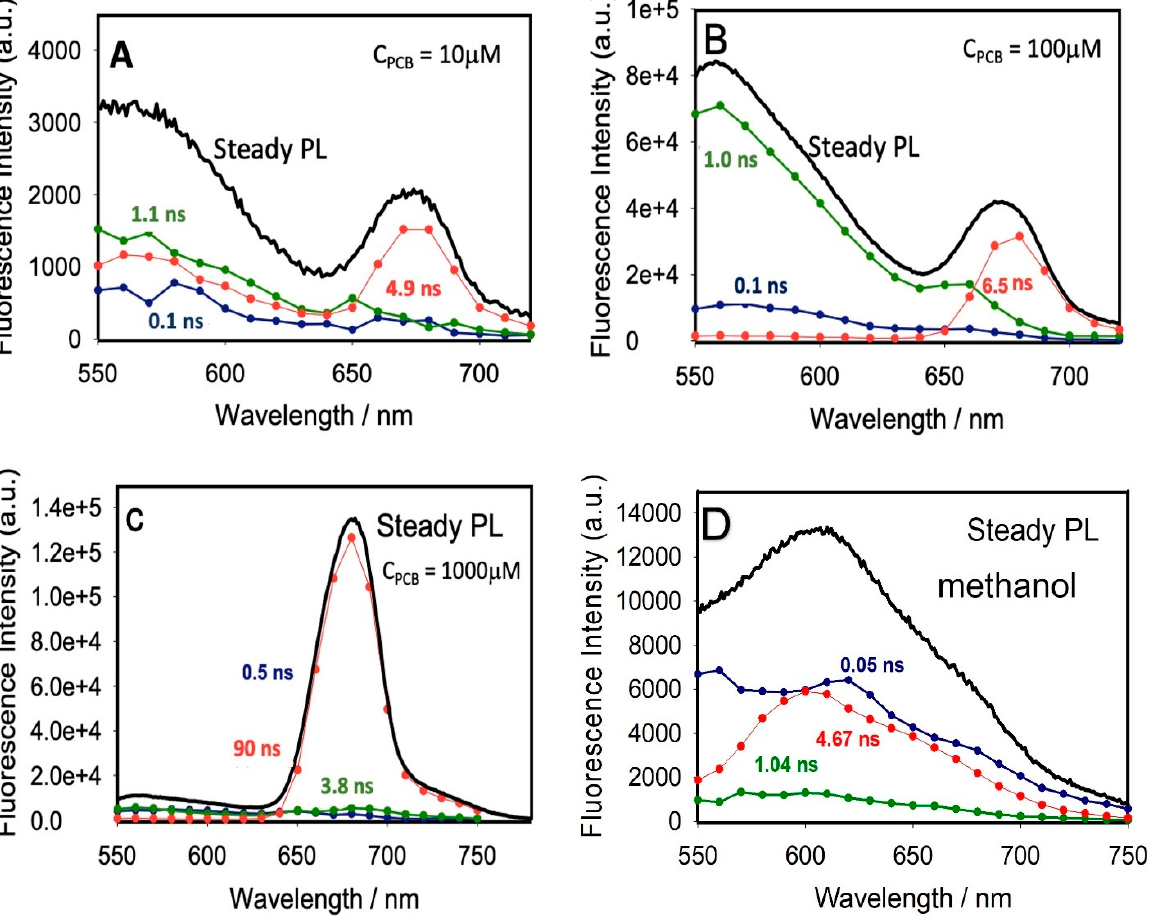
Figure 3. PL decays of solid 1000 µM-PCB@LDPE films at 298 K (black lines). The excitation and monitoring wavelengths are indicated directly in the graph (A and B). The data for LDPE (red lines) are added for comparison purposes.